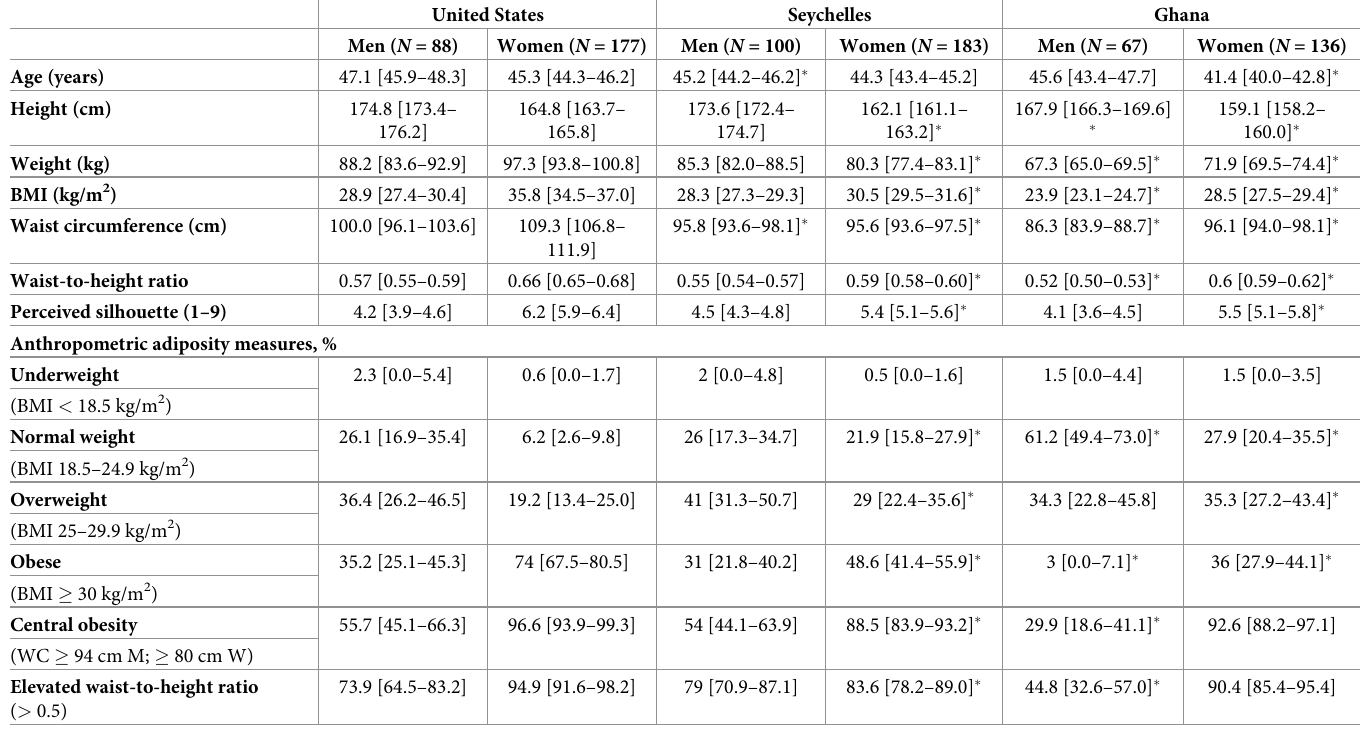
Table 1. Characteristics of participants in the United States, Seychelles, and